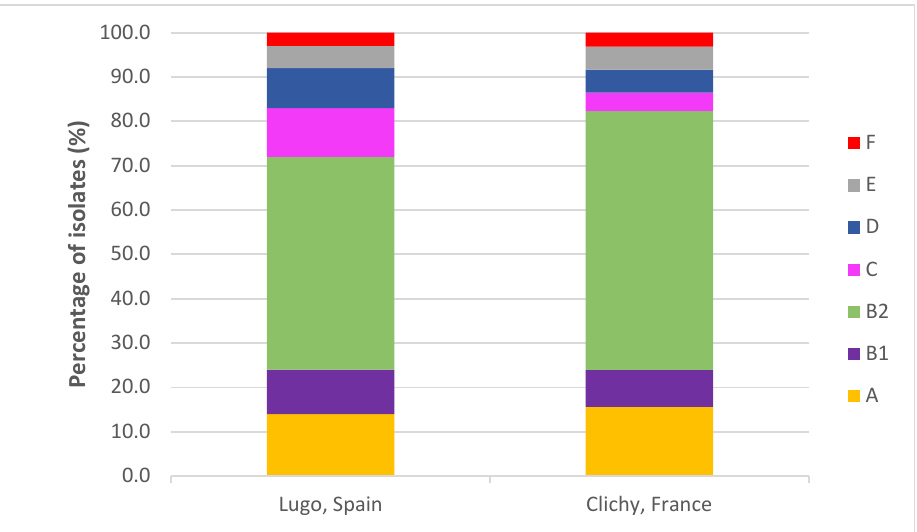
Figure 1. Comparison of the distribution of phylogenetic groups in the two hospitals.